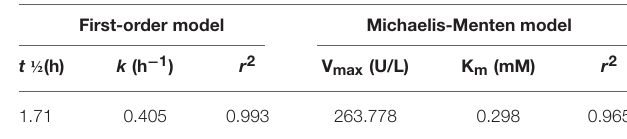
TABLE 3 | Parametric estimations and regression coefficients of the Michaelis-Menten model and a first-order deactivation model (1) applied to the thermal deactivation of the recombinant enzyme incubated at 50 ◦